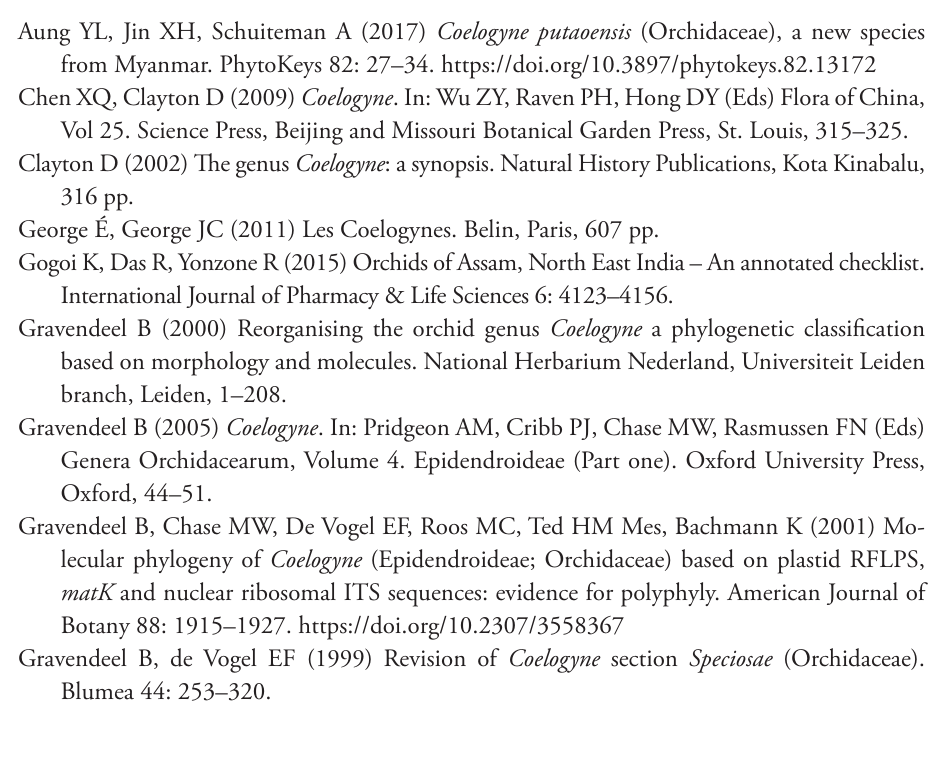
(vs. creamy yellow in C. taronensis ) (Figure 2), smaller leaf blades (Table 1), patches (two bright yellow patches vs. four dark red patches) and keels (two keels vs. three keels) on the lip. The major differences between the species are outlined in Table